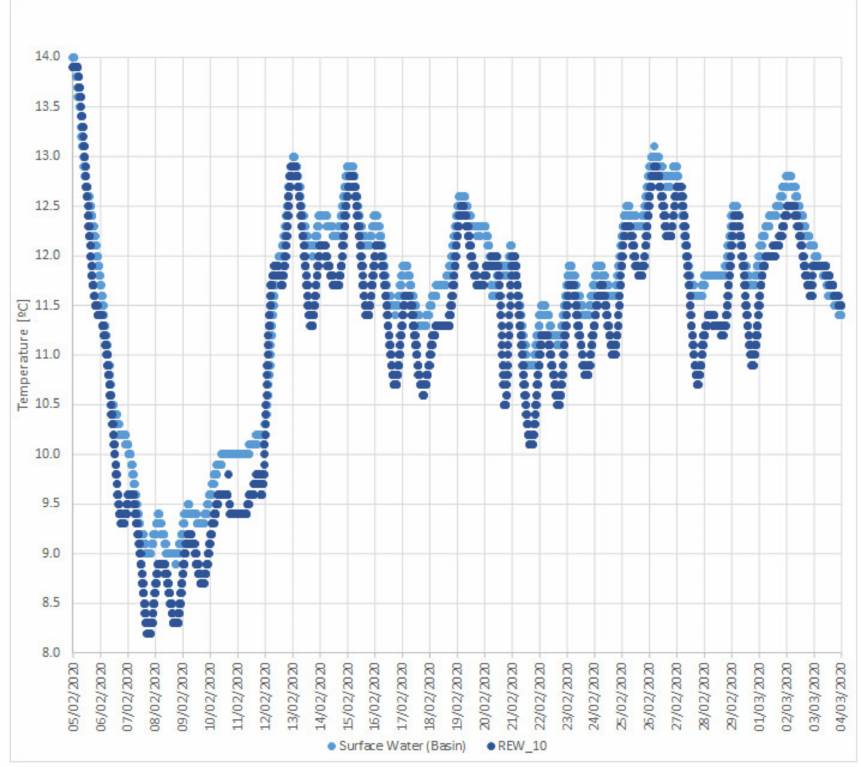
Figure 7. Recorded surface and groundwater temperature variations in the infiltration